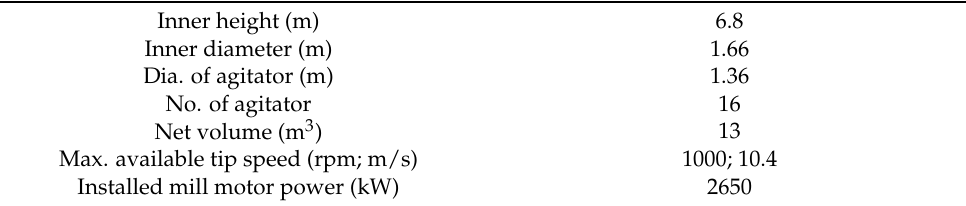
Figure 3. Flowsheet of milling and beneficiation circuit of the copper mine with IsaMill. The setup of the pilot scale IsaMill M20 is illustrated in Figure 4. The process enables multi-stage grinding/passing of the feed sample; hence, the signature plot can be devel- oped accordingly.